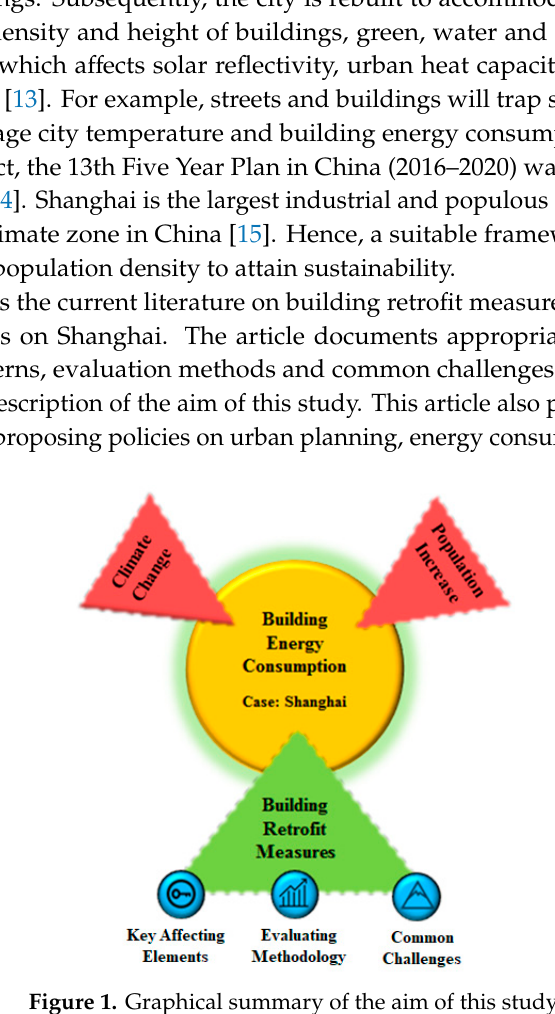
Figure 1. Graphical summary of the aim of this study.